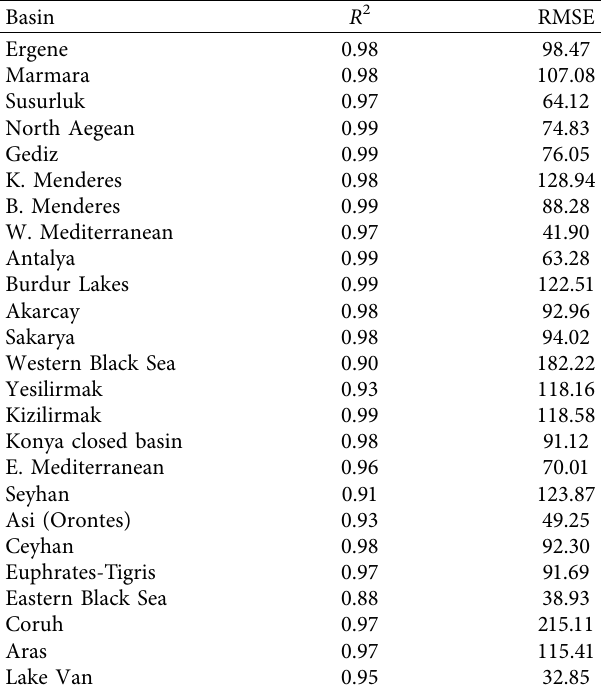
Table 6: R 2 and RMSE results for TRMM data.